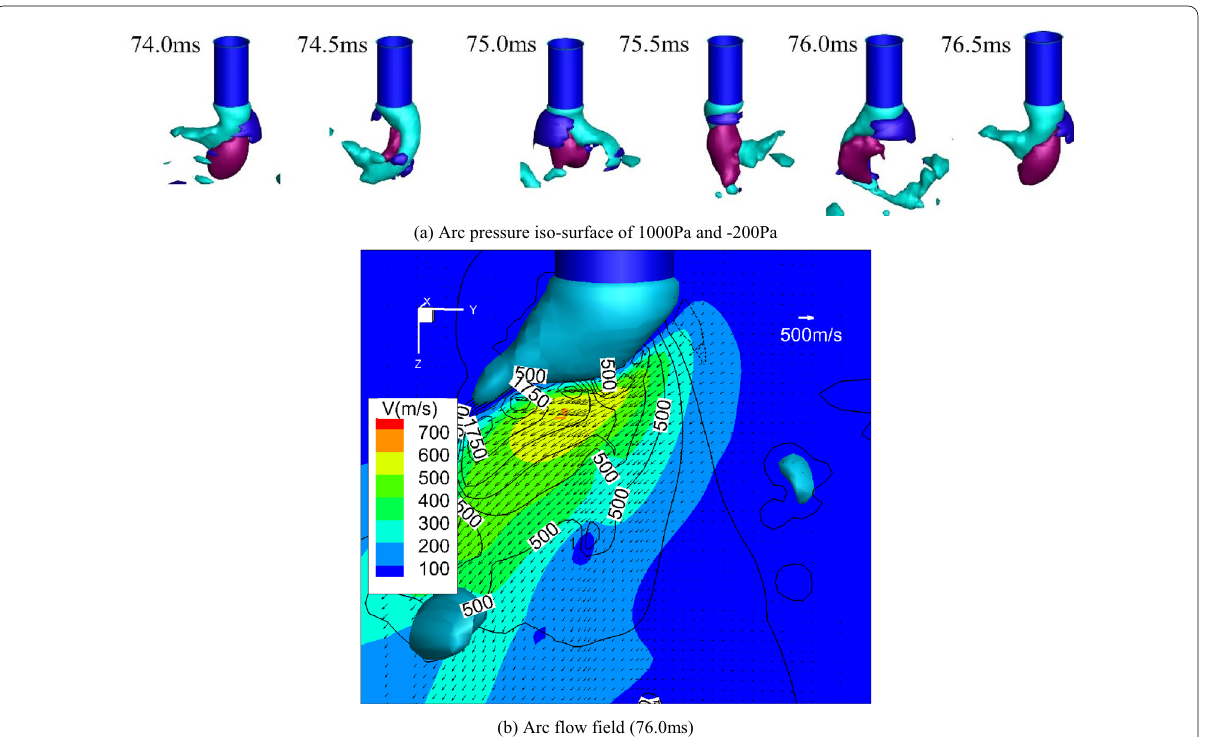
Figure 10 Arc pressure field and flow field in 500 A MAG